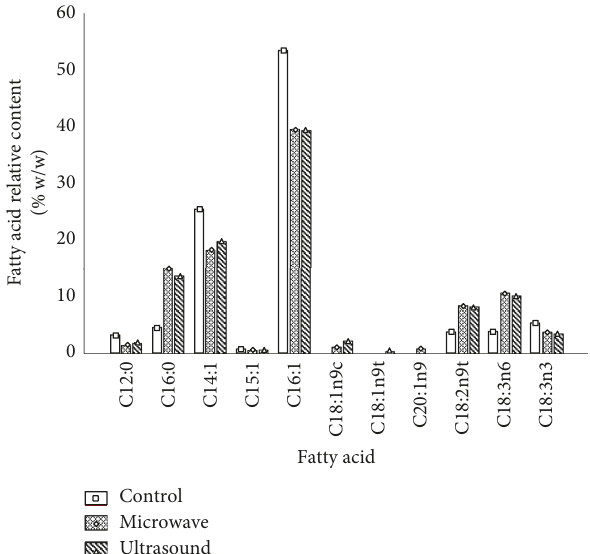
Figure 2: Fatty acid profiles (%) of Chaetoceros calcitrans in different methods of cell disruption. C12 :0, lauric acid; C16: 0, palmitic acid; C14:1, tetradecenoic acid; C15 :1, pentadecenoic acid; C16 :1, palmitoleic acid; C18 :1n9c, oleic acid; C18 :1n9t, elaidic acid; C20 :1n9, eicosenoic acid; C18 :2n9t, linoleic acid; C18 :3n6, c -linolenic acid; C18: 3n3, α -linolenic acid. Table 1: Energy consumption of experimental methods of cell disruption applied to the microalga Chaetoceros calcitrans .